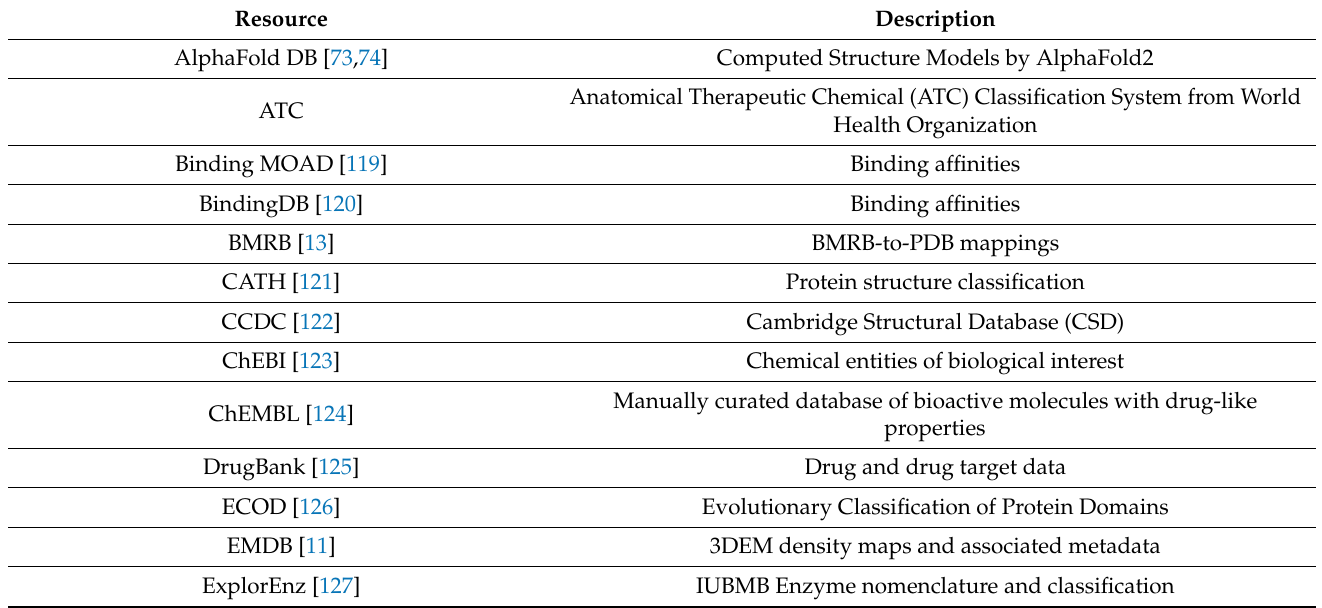
Figure 8. ( A ). Geographic distribution of RCSB.org users by country. ( B ). Top 10 countries with the highest percentage of users from 2019–2021. Data from Google Analytics. Table 1. Trusted external resources/data content integrated weekly with PDB archival data by RCSB PDB from rcsb.org/docs/general-help/data-from-external-resources-integrated-into-rcsb-pdb (accessed on 28 August 2022). (N.B.: In response to community input, RCSB PDB continues to integrate new external data